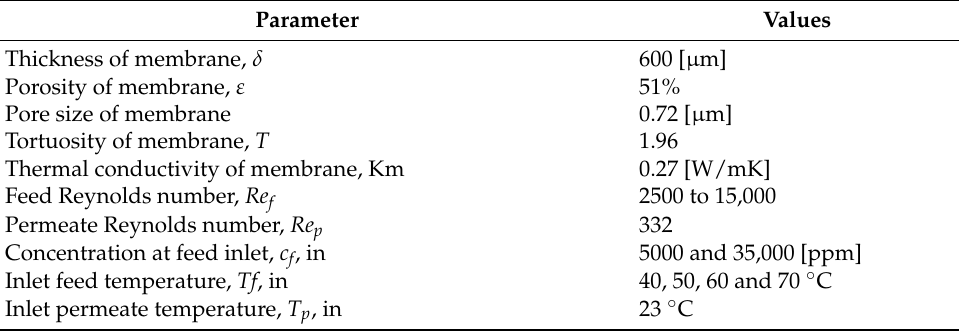
Table 3. Membrane specifications and operating conditions used in the